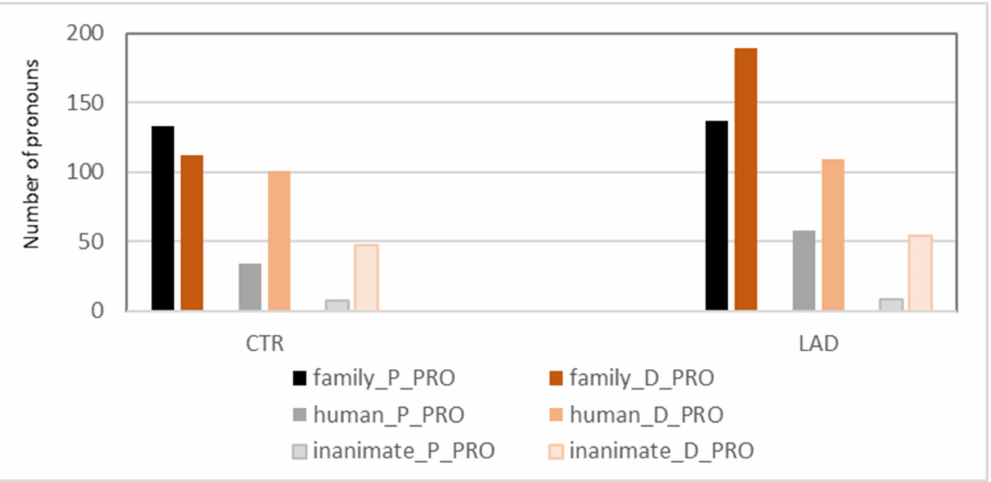
Figure 4. Classes of referents of personal pronouns and D-pronouns (singular pronouns